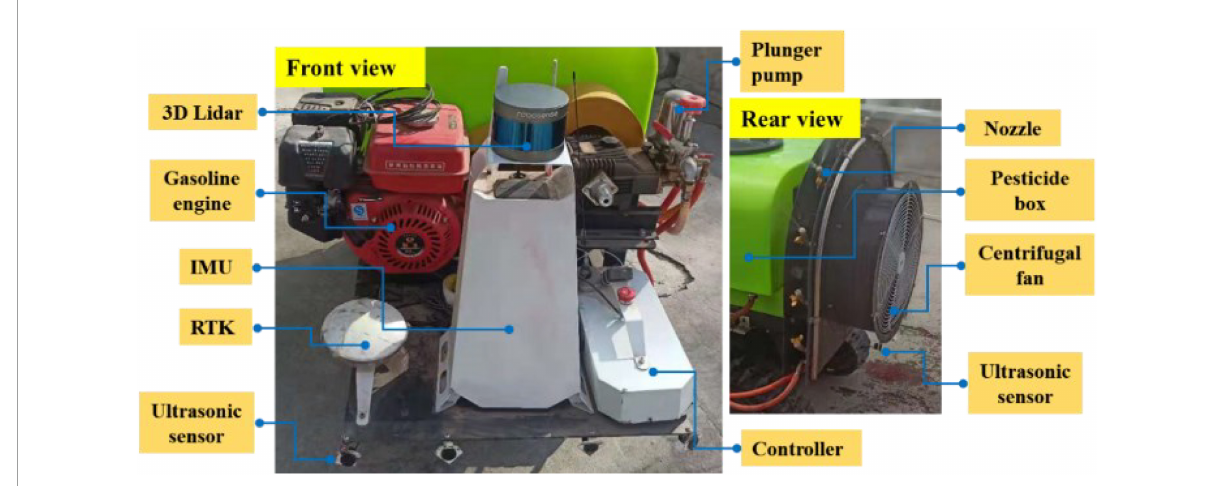
FIGURE3 The main hardware distribution of the orchard autonomous navigation spray system.